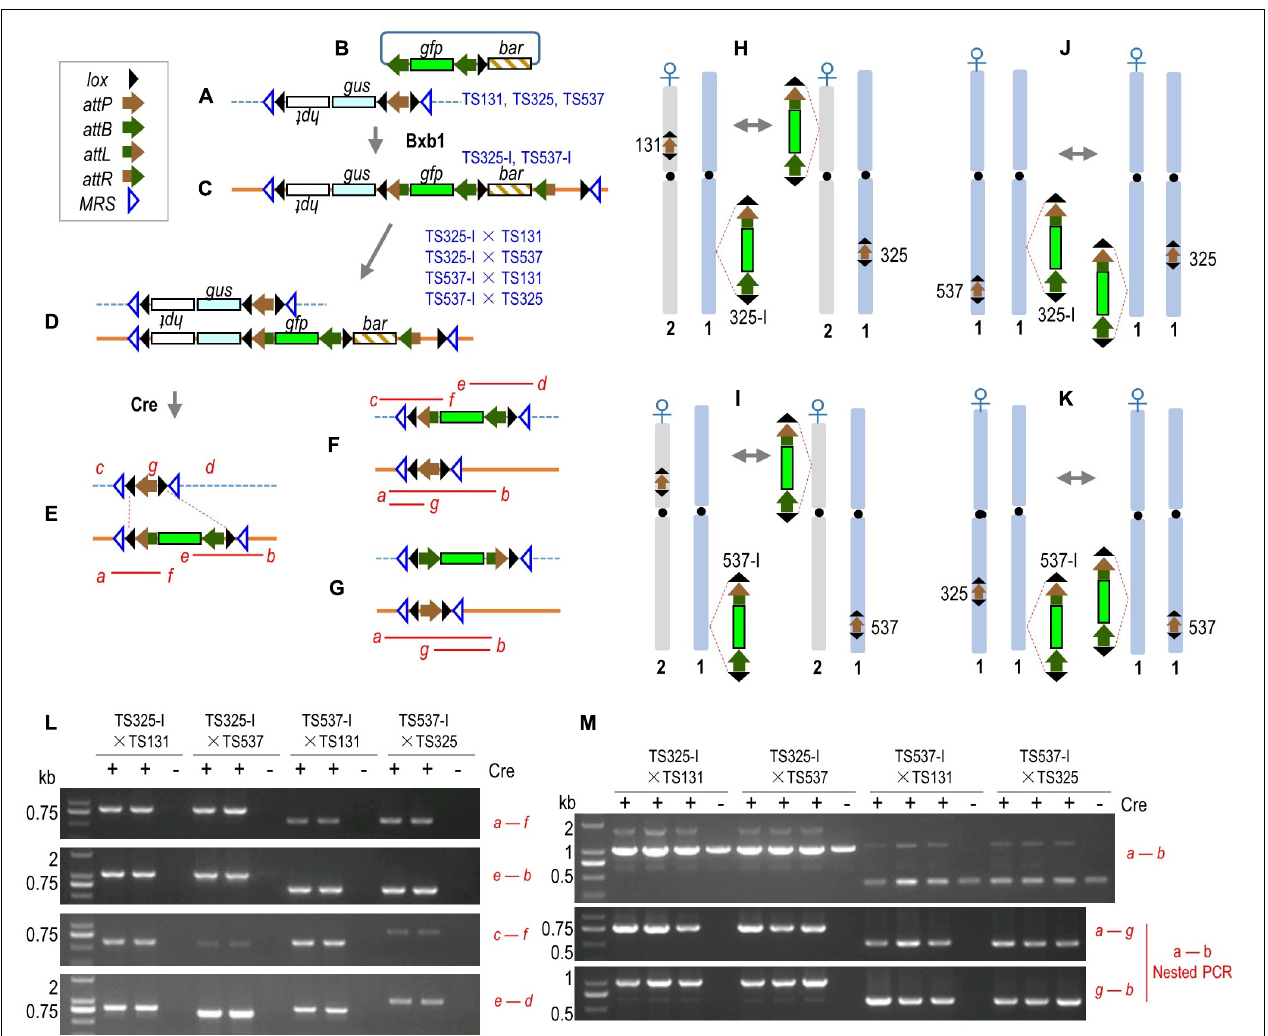
FIGURE 1 | Cre-mediated recombination between different target sites. (A) Rice target lines TS131, TS325, and TS537 structure. (B) Integrating vector pZH210B was inserted into TS325 and TS537 to form TS325-I and TS537-I, respectively (C) . F1 hybrids from crosses (D) and expected structures from Cre-mediated deletion of DNA flanked by directly oriented lox sites (E) ; inversion from recombination of oppositely oriented lox sites not shown. Translocation of gfp -containing segment to another chromosome (F) and after inversion (G) . Red italic letters, PCR primers; red lines, PCR products. (H–K) Chromosome location of target sites in TS131, TS325, and TS537 with relevant lox sites and the direction of attP . Crosses with gfp -stacked lines (i.e., 325-I and 537-I) leads to Cre-mediated reciprocal translocation of the lox -flanked DNA. (L,M) PCR results from deletion and chromosome recombination in F1 + cre plants. Genes described in the Methods section and were transcribed in direction of lettering, promoters, and terminators not shown. Recombination sites indicated in inset legend. DNA size is mentioned in